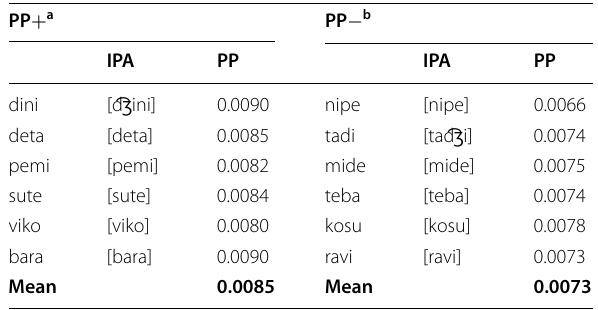
Table 1 Phonetic transcription (IPA), Phonotactic Probabilities (PP) of the set with pseudowords with highest possible phonotactic probabilities (PP ) and the set with the lower + phonotactic probabilities (PP −